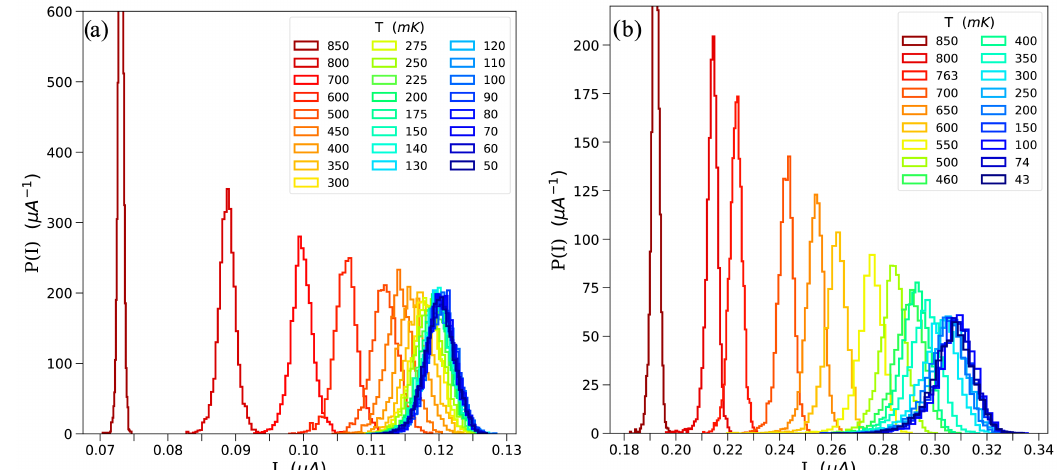
2 µ m junction ( a ) and for 2 µ m 4 µ m junction ( b ). The ranges of Figure 7. Filtered escape current distributions for 2 µ m × × temperatures are slightly different and are shown in the legends. Rightmost curves are taken at the lowest temperature and leftmost curves are taken at highest temperature. The effect of the filter was a reduction of σ up to 20% with respect to the unfiltered data (not shown); was left unchanged. I c (cid:104) (cid:105)